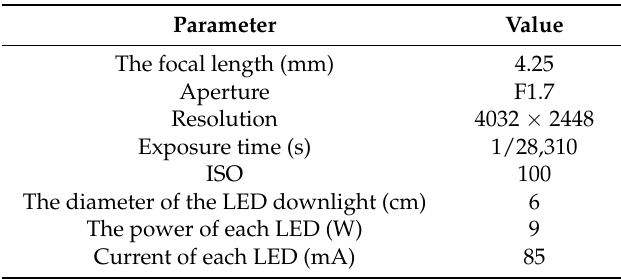
Table 2. Parameter of the Experiment.